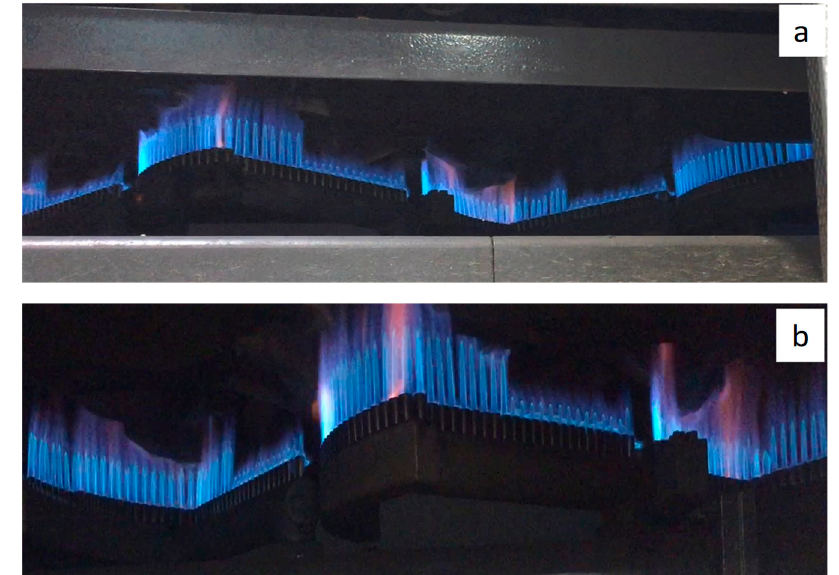
Figure 8. Flame colour before ( a ) and after ( b ) combustion air preheating.